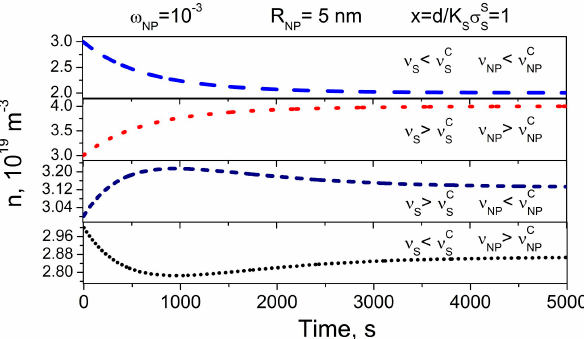
Figure 4. Time dependence of the volume concentration of mobile ions n in liquid crystals doped with contaminated nanoparticles and sandwiched between contaminated substrates. The radius of nanoparticles is 5 nm, and their weight concentration is 0.001. The dimensionless parameter x = 1. The contamination factors of both nanoparticles and substrates are varied: dashed curve ( v S = 10 − 3 < = 3 × 10 − 3 , v = 2 × 10 − 4 < ν C = 3 × 10 − 4 ); dotted curve ( v = 5 × 10 − 3 > ν C = 3 × 10 − 3 , ν C NP S NP S S = 3 × 10 − 4 ); short-dashed ( v = 5 × 10 − 3 > ν C = 3 × 10 − 3 , v = 2 × 10 − 4 < v NP = 4 × 10 − 4 > ν C NP S NP S = 3 × 10 − 4 ); short-dotted ( v = 10 − 3 < ν C = 3 × 10 − 3 , v = 4 × 10 − 4 > ν C = 3 × 10 − 4 ν C NP S NP NP S